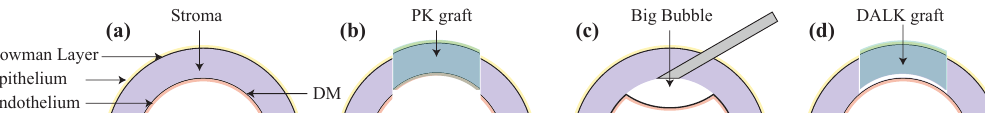
Figure 1. ( a ) Corneal micro-anatomical structure with epithelium, Bowan layer, stroma, Descemet’s membrane (DM), and endothelium. ( b ) Penetrating keratoplasty (PK) with full thickness corneal grafting. ( c ) Deep anterior lamellar keratoplasty (DALK) with big bubble formation. ( d ) DALK with partial thickness corneal